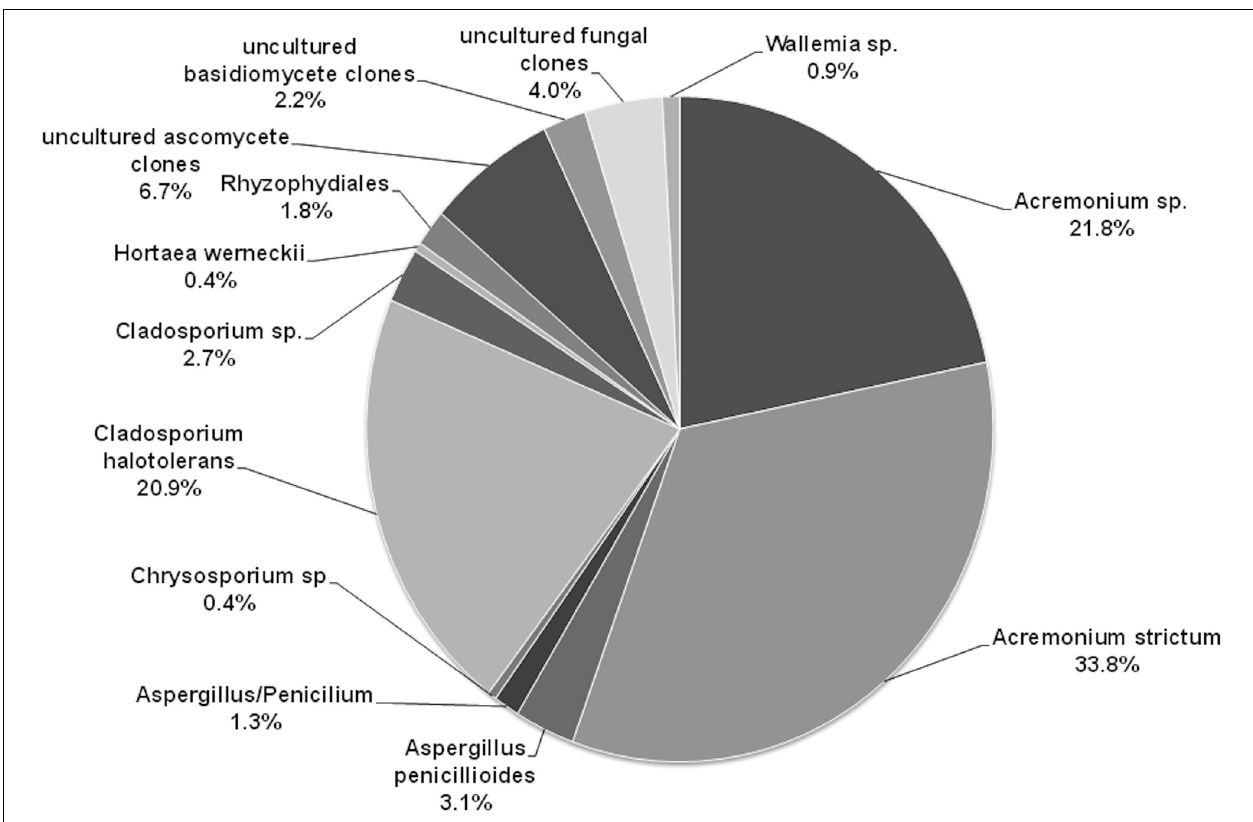
FIGURE 2 | Diversity of fungi in the mature microbial mat based on clone libraries. The figure shows the percentage of each fungal species detected within the 225